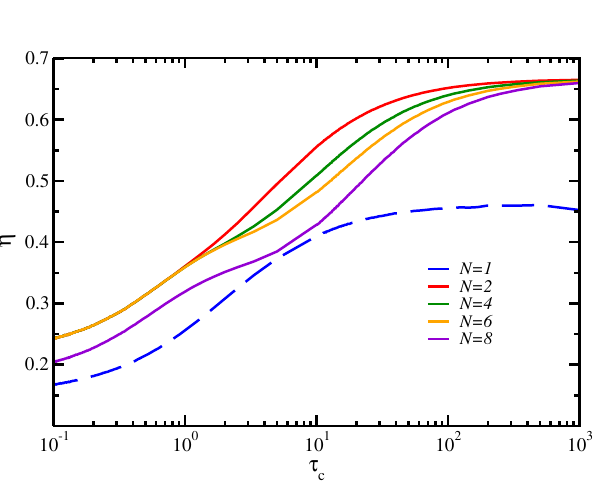
2 (cid:30) / R vs noise L 2 = γ = k = k C = 1 , V = 0 , m = 1 , and c = k v = 0